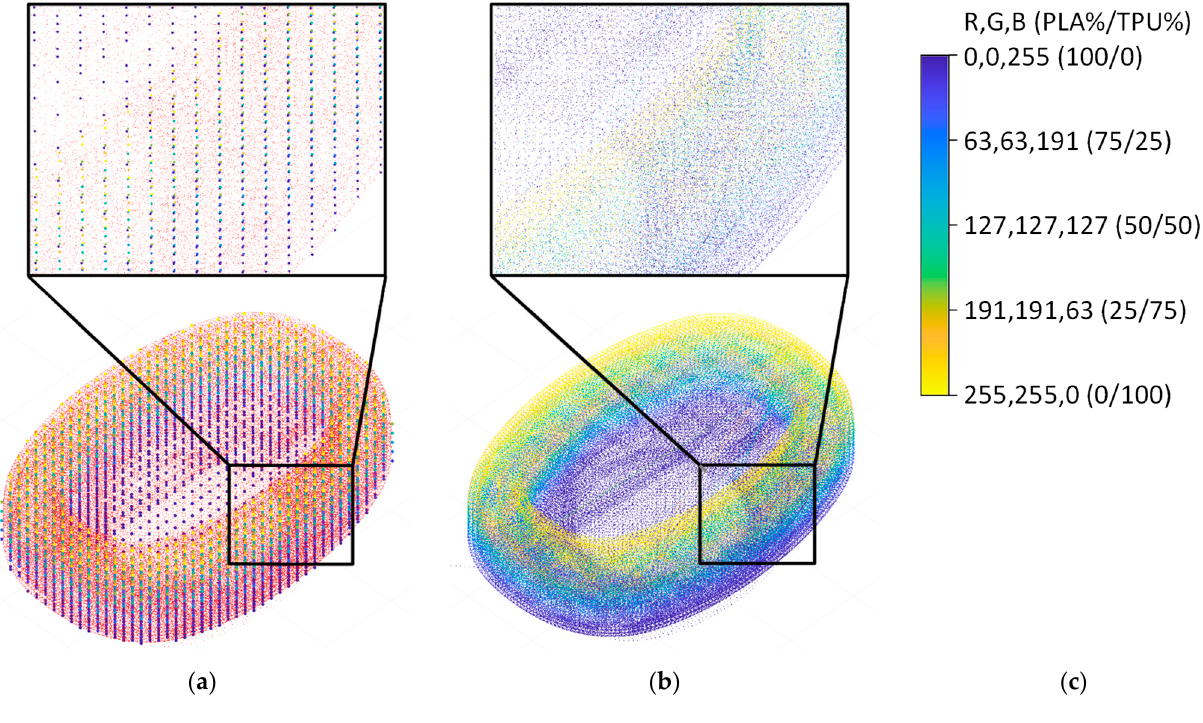
Figure 7. ( a ) Overlapping of the two-point clouds, i.e., the point cloud of the volumetric information and the point cloud of the path of the tool (the small points). ( b ) Point cloud of the path of the tool with the additional information regarding the material properties visualized with a grade of colors. ( c ) Color map.